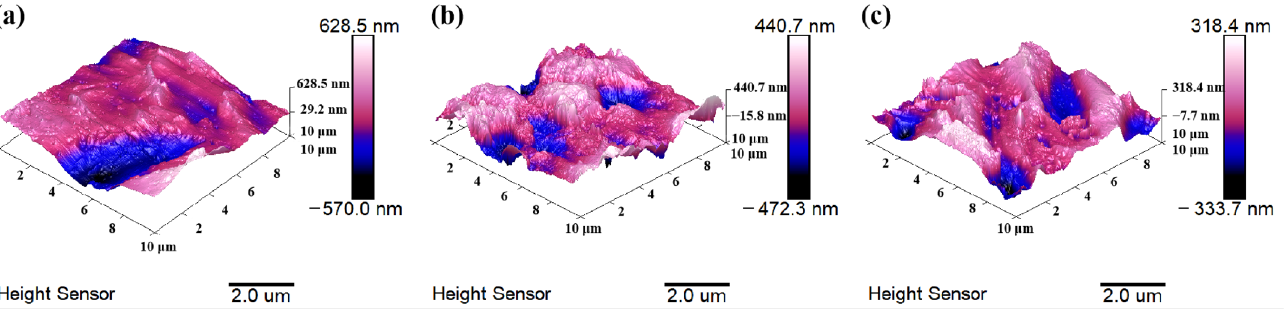
Figure 14. Atomic force micrographs taken on the erosion–corrosion surfaces of the coatings: ( a ) Fe- based coating, ( b ) 6% γ -Fe coating, and ( c ) 9% γ -Fe coating.